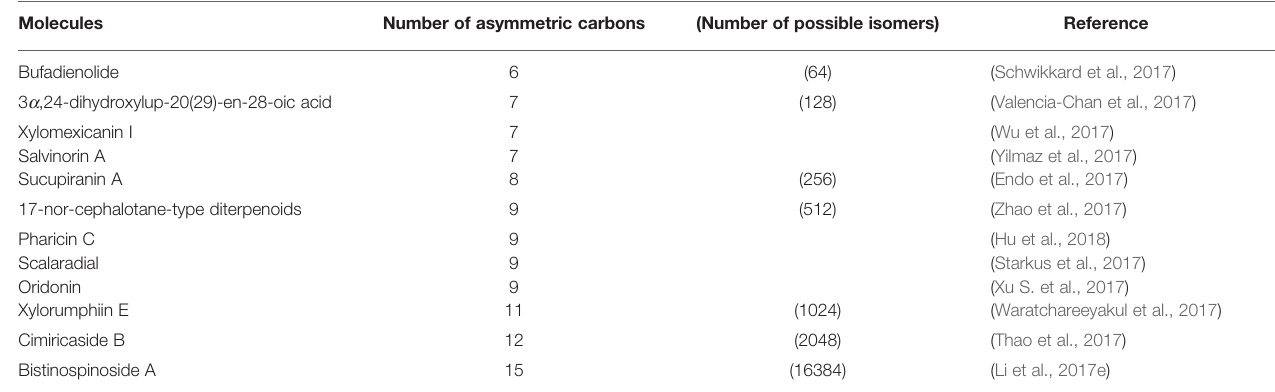
TABLE 5 | Examples of asymmetric carbons in natural products. Molecules Number of asymmetric carbons (Number of possible isomers)